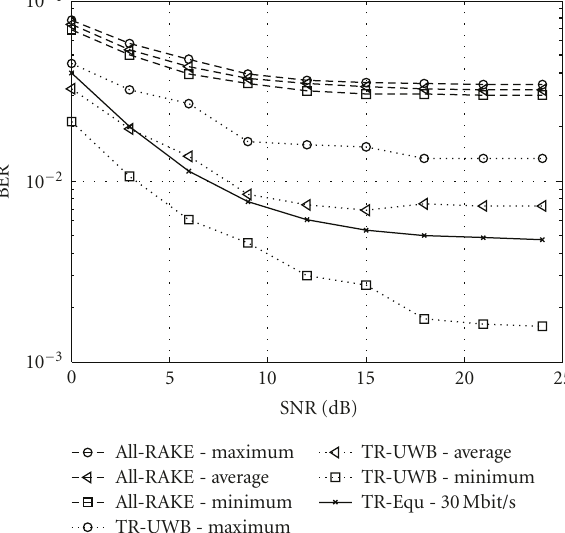
Figure 9: BER curves for ISI with Reed-Solomon coding ( N s = 10).